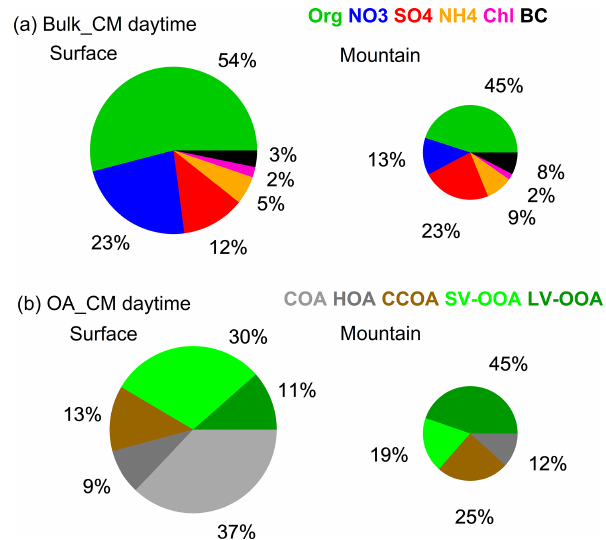
Figure 3. Averaged chemical composition at both sites during the convective mixing (CM) daytime period (11:00–14:00). (a) Bulk aerosols. (b) Organic